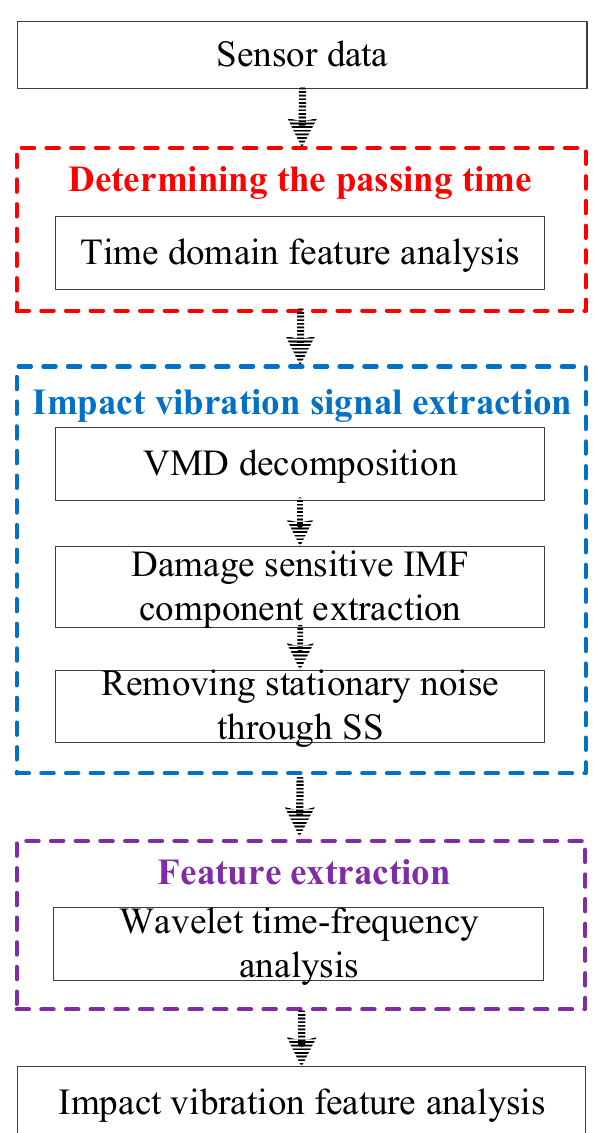
Figure 1. The flow chart of signal processing.